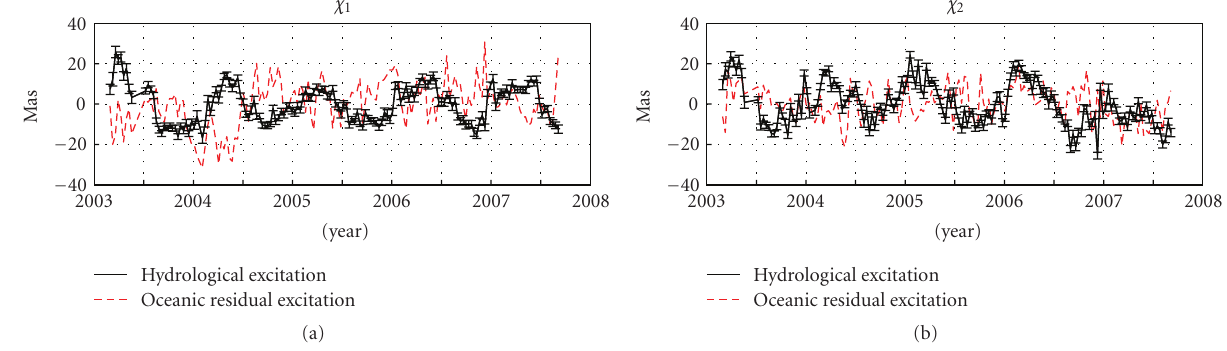
Figure 1: Oceanic residual excitation (mask over continents) and hydrological excitation (mask over oceans) estimated by integrating GRACE equivalent water height grids. We observed a significant oceanic residual signal. Bars represent the calibrated errors provided by the GRGS.